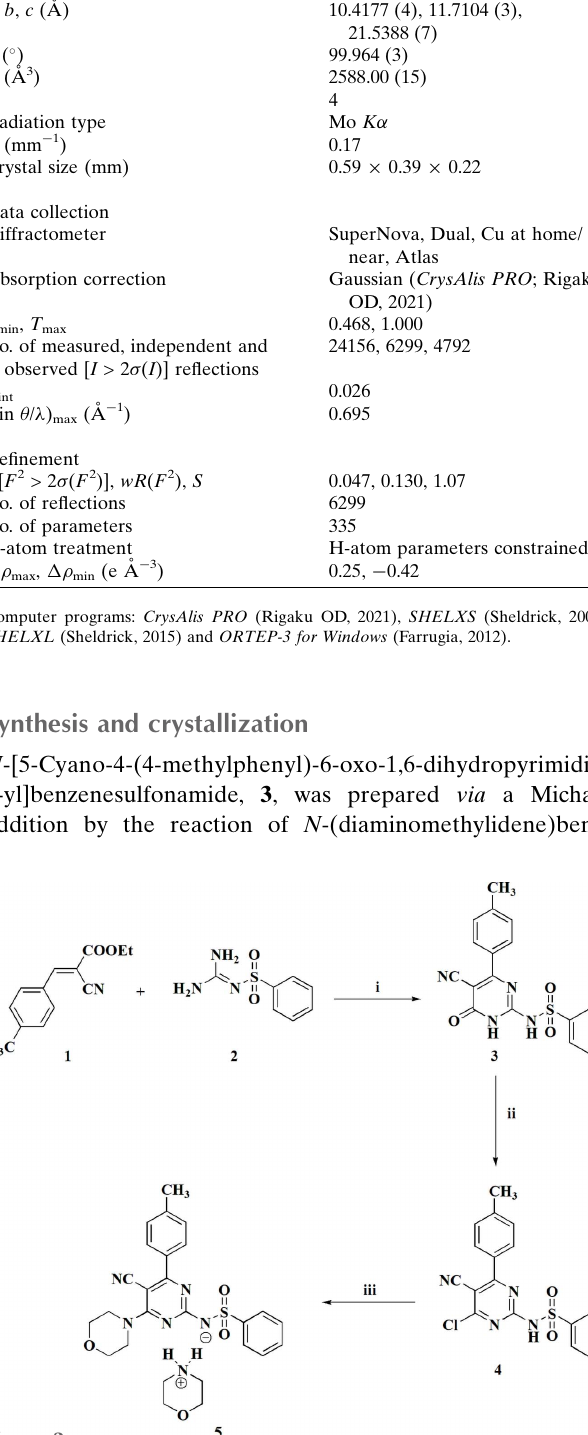
Figure 3 Reaction scheme. Reagents and conditions: (i) potassium hydroxide; dioxane; reflux; 2 h, (ii) phosphorus oxychloride; reflux; 1 h, and (iii) morpholine; potassium carbonate; dioxane; reflux; 2